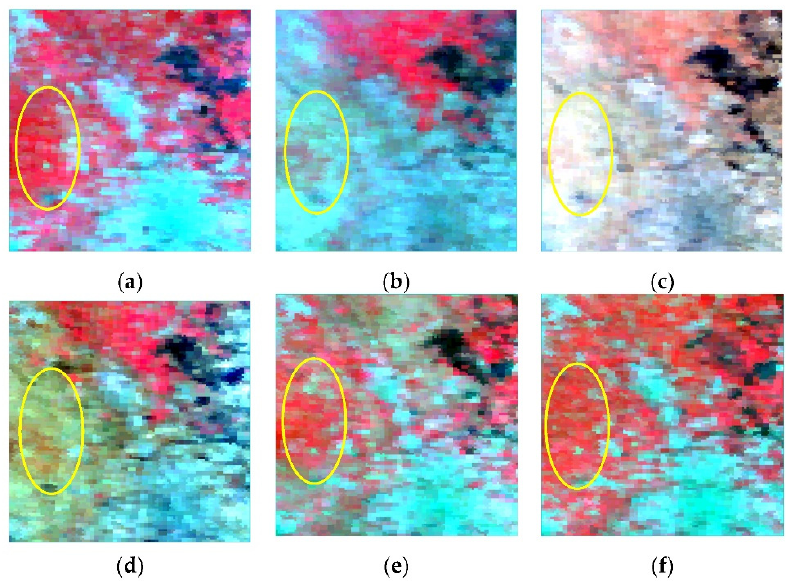
Figure 9. MODIS images from the Tianjin dataset reflecting changes in urban phenology. Dates: ( a ) August 2019.